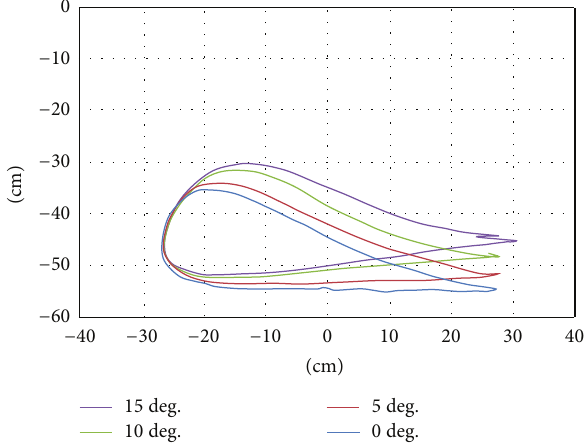
Figure 4: Trajectories of foot during walking on real slopes.